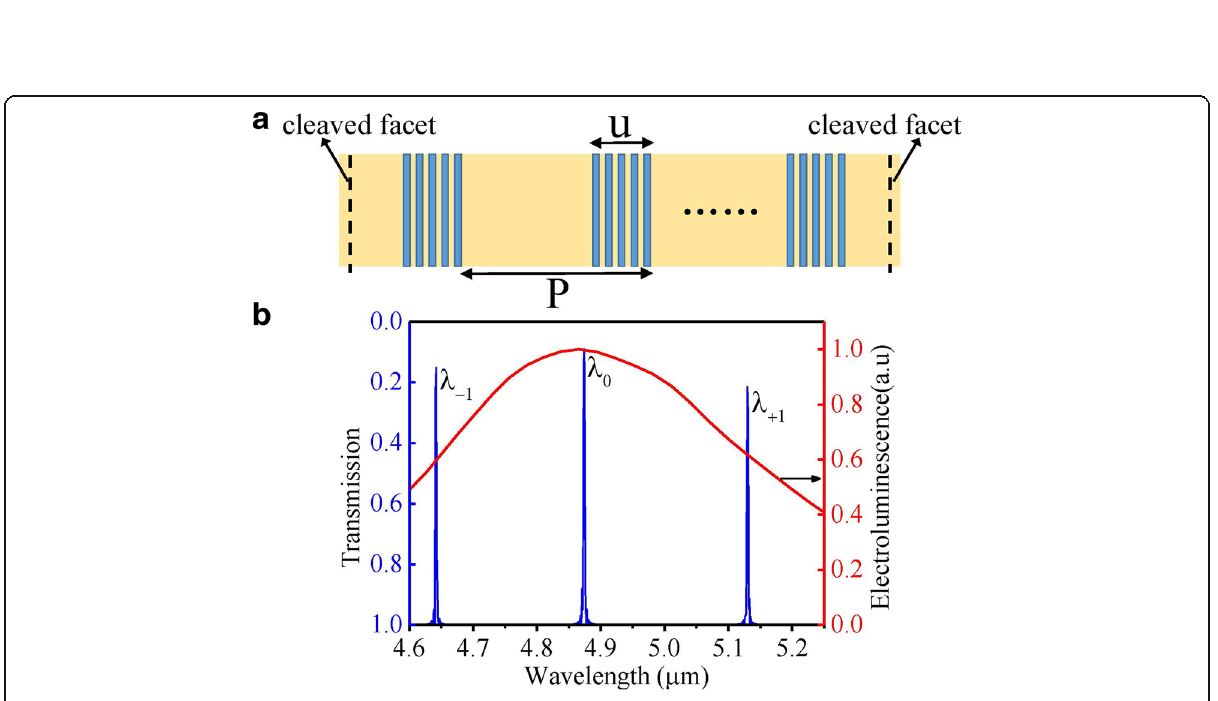
Fig. 3 a The diagram of the sampling grating structure, the vertical dotted line represents the cleaved facet position, P is the sampling period, and u is the length of the grating region in one sampling period. b The blue line is the calculated transmission spectrum of the designed sampled grating, and the red line is the measured electroluminescence spectrum of the fabricated